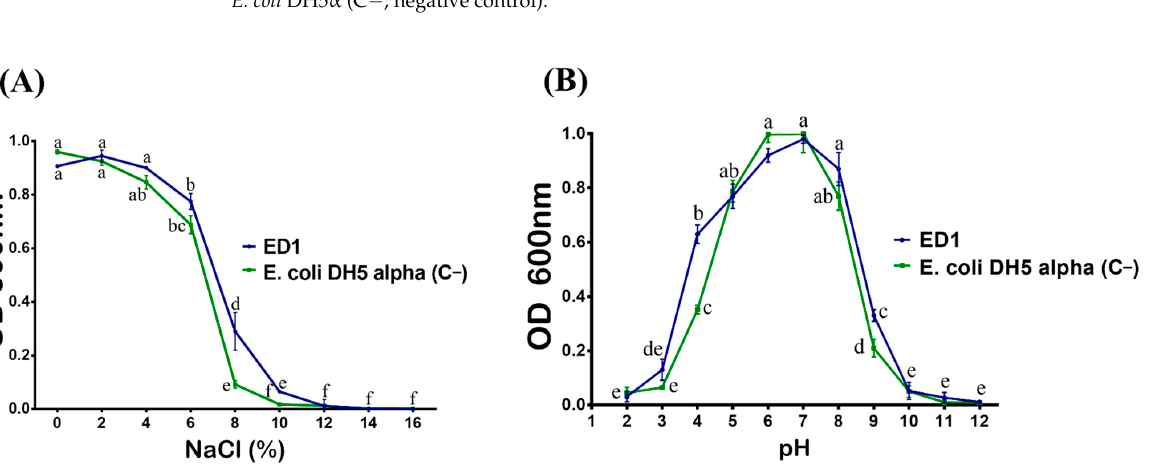
Table 2. Summary of relevant extreme properties of isolated endophytic bacterium Serratia rubidaea ED1, the PGPR reference strain B. licheniformis QA1, and E. coli DH5 α (C − ).